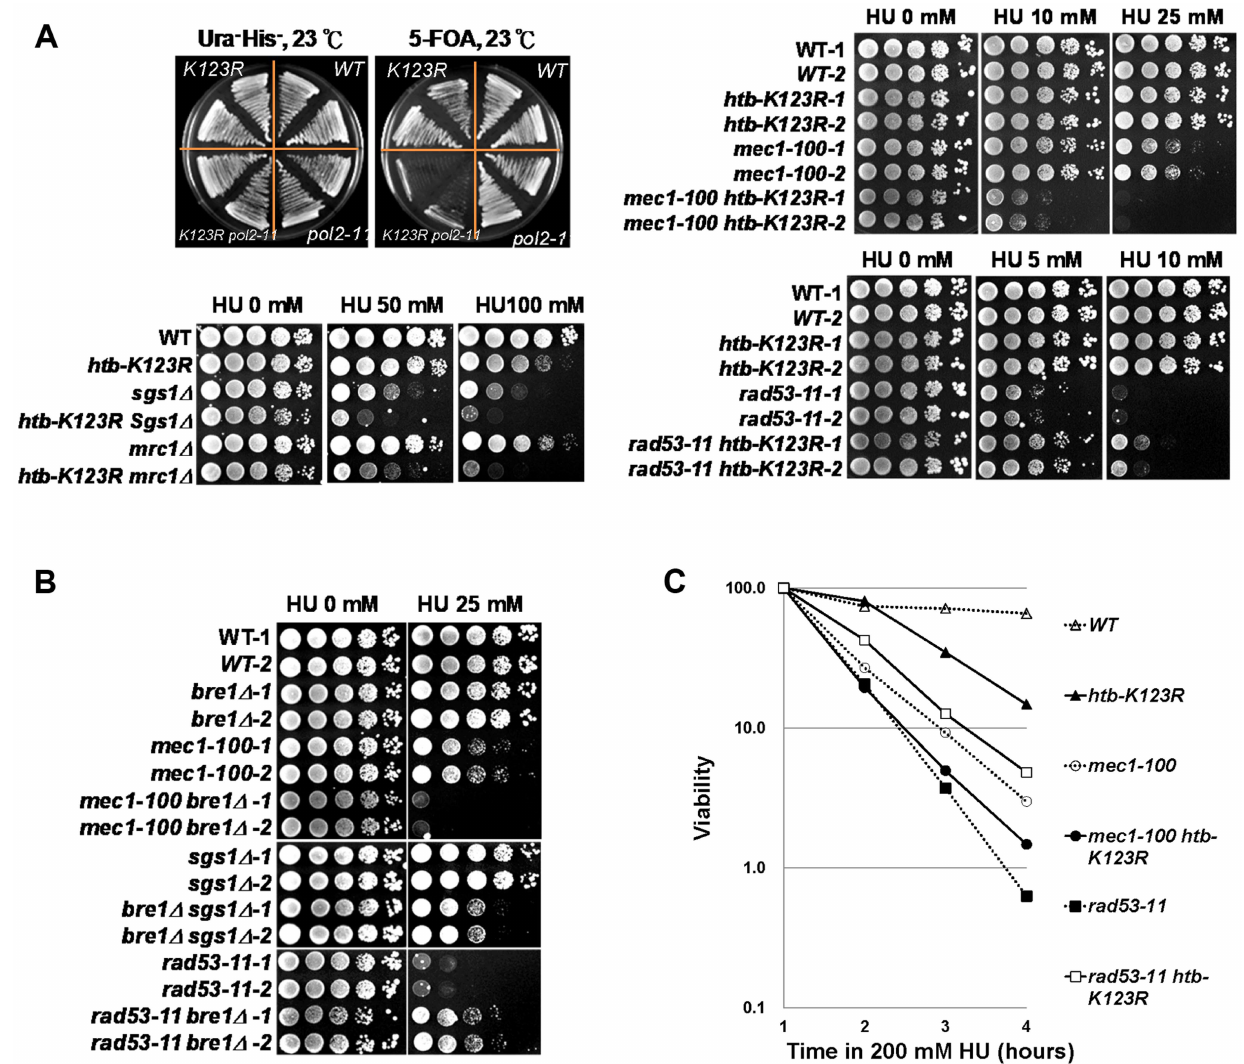
Figure 4. The Bre1-H2Bub pathway genetically interacts with components of the intra-S-phase checkpoint. (A) H2Bub functions in parallel with DNA polymerase ( pol2-11 ) and intra-S-phase checkpoint cascades (Mec1, Sgs1, and Mrc1). WT and pol2-11 cells carrying HTB1 or the htb1-K123R allele on a HIS3 vector were transformed with HTB1 on a URA3 vector. The strains containing both URA3 and HIS3 (CFK2000, CFK2002, CFK2004, and CFK2006) were streaked onto 5-FOA plates to select for cells lacking H2Bub ( htb1-K123R ). Ten-fold serial dilutions of the indicated strains were spotted onto YPD plates in the absence or presence of different doses of HU at 30 u C (WT (CFK1204, CFK2352, and CFK2414), htb-K123R (CFK1231 and CFK2416), mec1-100 (CFK2346), sgs1 D (CFK1447), mrc1 D (CFK1444), rad53-11 (CFK2347), and double mutants (CFK2356, CFK1453, CFK1450, and CFK2358)). (B) The H2B ubiquitin E3 ligase, Bre1, functions in parallel with intra-S-phase checkpoints under HU stress. Ten-fold serial dilutions of the indicated strains (WT (CFK2351), bre1 D (YMW093), mec1-100 (CFK2346), mec1-100 bre1 D (YMW095), sgs1 D (CFK2371), bre1 D sgs1 D (CFK2373), rad53-11 (CFK2347), and rad53-11 bre1 D (CFK2378)) were spotted onto YPD plates with and without HU as described in (A). (C) The response of double mutants of htb-K123R and mec1-100 or rad53-11 to acute exposure to HU. Logarithmically-growing cells were treated with 0.2M HU as described in Fig. 1A.